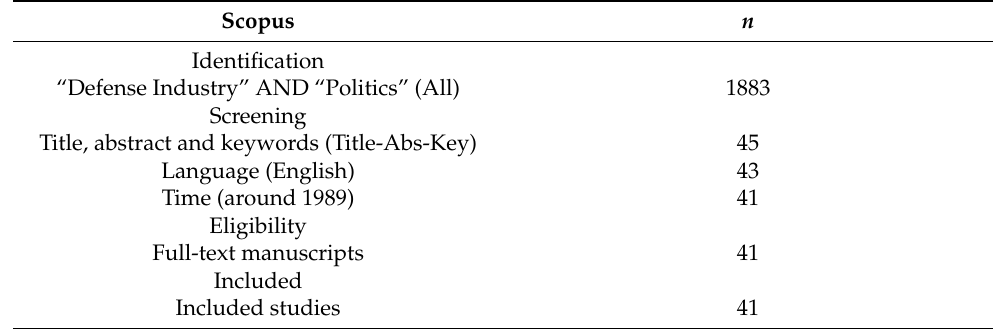
Table 1. Four phases of preferred reporting items for systematic reviews and meta–analysis (PRISMA) protocol (source: own